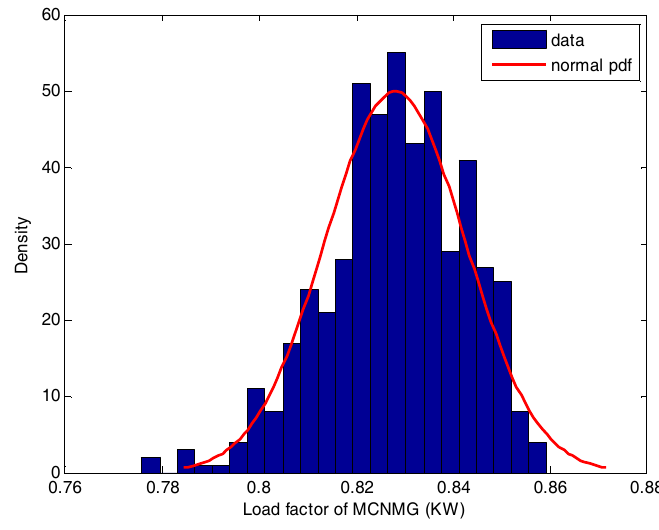
Figure 13. PDF of load factor.